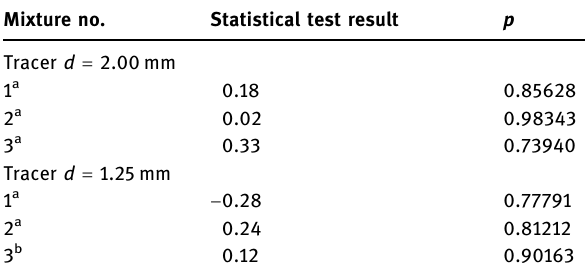
Table 4: Results of statistical comparative analysis of the tracer ’ s share obtained by the two methods Mixture